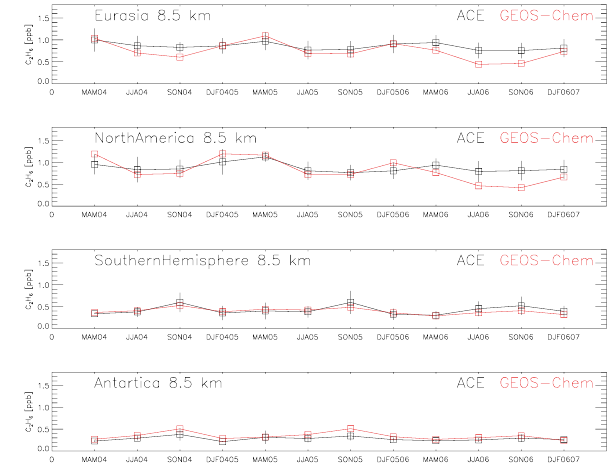
Fig. 13. Seasonal and hemispheric variations of C 2 H 6 volume mix- ing ratios observed (black) and simulated (red) averaged in different regions at 8.5km.